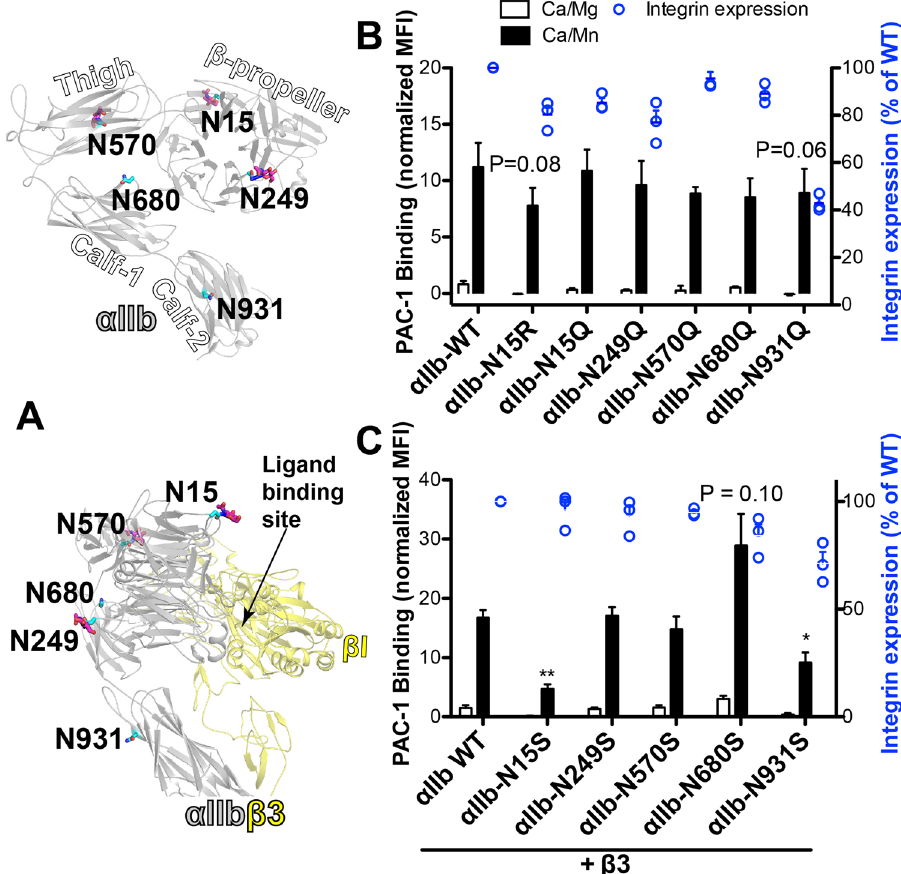
Figure 2. Effect of the individual N-glycan deletion of α IIb subunit on α IIb β 3 ligand binding. (A) Locations of α α β IIb N-glycan sites in the crystal structure of IIb 3 (PDB code 3FCS) at the bent conformation. Asn residues are shown as sticks with carbons in cyan. N-glycan residues resolved in the crystal structure are shown as sticks with carbons in magenta. Oxygens and nitrogens are red and blue, respectively. It should be noted that the N-glycan residues visualized in the crystal structure are trimmed ones. The native N-glycan chains could be much longer and more complex. (B , C) Ligand-mimetic mAb PAC-1 binding of the indicated single mutations of α IIb co-expressed with β 3 in HEK293FT cells in the presence of 1 mM Ca 2 + / Mg 2 + (Ca/Mg) or 0.2 mM Ca 2 + plus 2 mM Mn 2 + (Ca/Mn). PAC-1 binding was measured by flow cytometry and presented as mean fluorescence intensity (MFI) normalized to integrin expression (AP3 binding). Data are means ± s.e.m. (n ≥ 3). Two- tailed t-tests were used to compare the wild type (WT) and the mutants in the Ca/Mn condition. * P < 0.05; ** P <